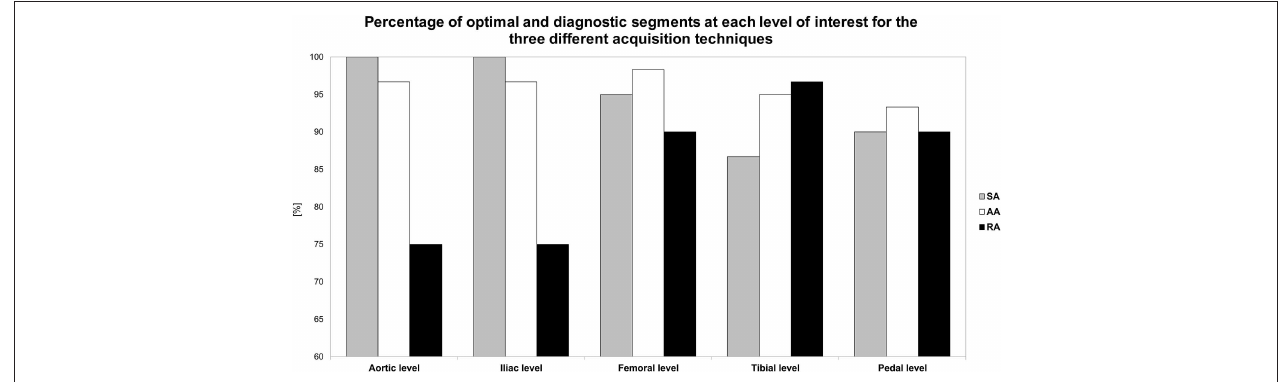
FIGURE 3 | Bar graph represents the percentage of optimally enhanced segments on axial reconstructions for each of the three acquisition techniques. SA, standard acquisition technique; AA, adaptive acquisition technique; RA; retrograde acquisition technique.